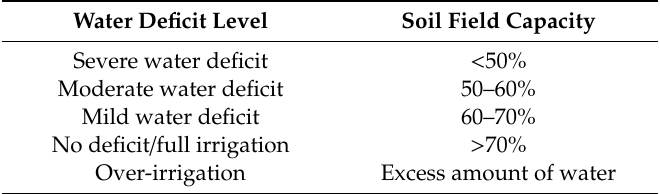
Table 2. Water deficit level in relation to a percentage reduction in soil field capacity.